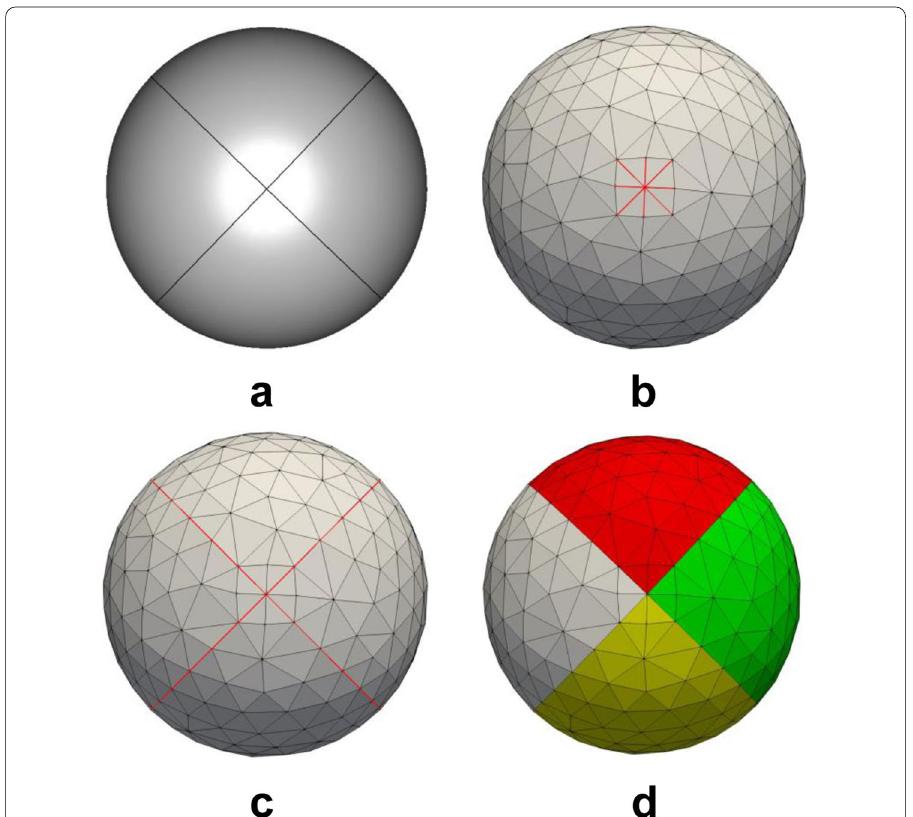
Fig. 6 An example illustrating the process of setting up three basic mappings between a CAD model and a surface mesh created on the model. a is the example sphere model composed of 4 surface patches. In ( b ), a surface mesh vertex at the center of four colored edges is highlighted, which is searched and classified on the corresponding model point. In ( c ), all the edges classified on the model curves are colored. In ( d ), the surface facets are colored differently, illustrating that they are classified on different surface